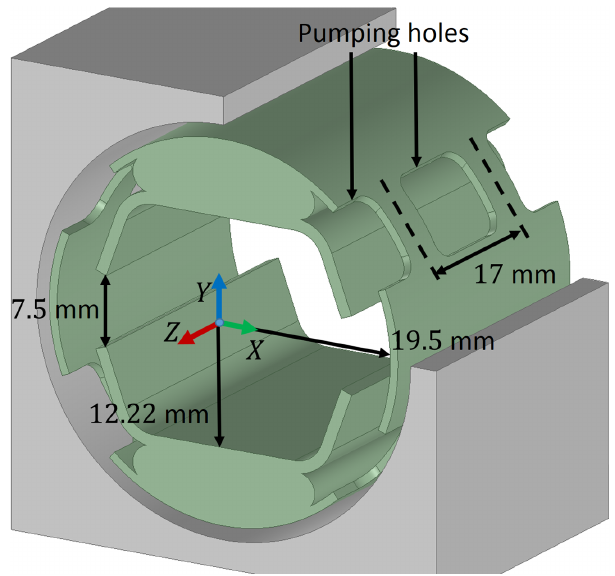
FIG. 1. FCC-hh beam screen (green) inside a magnet cold bore (gray). Only the features important to the study are shown, which excludes the cooling channel and the surface